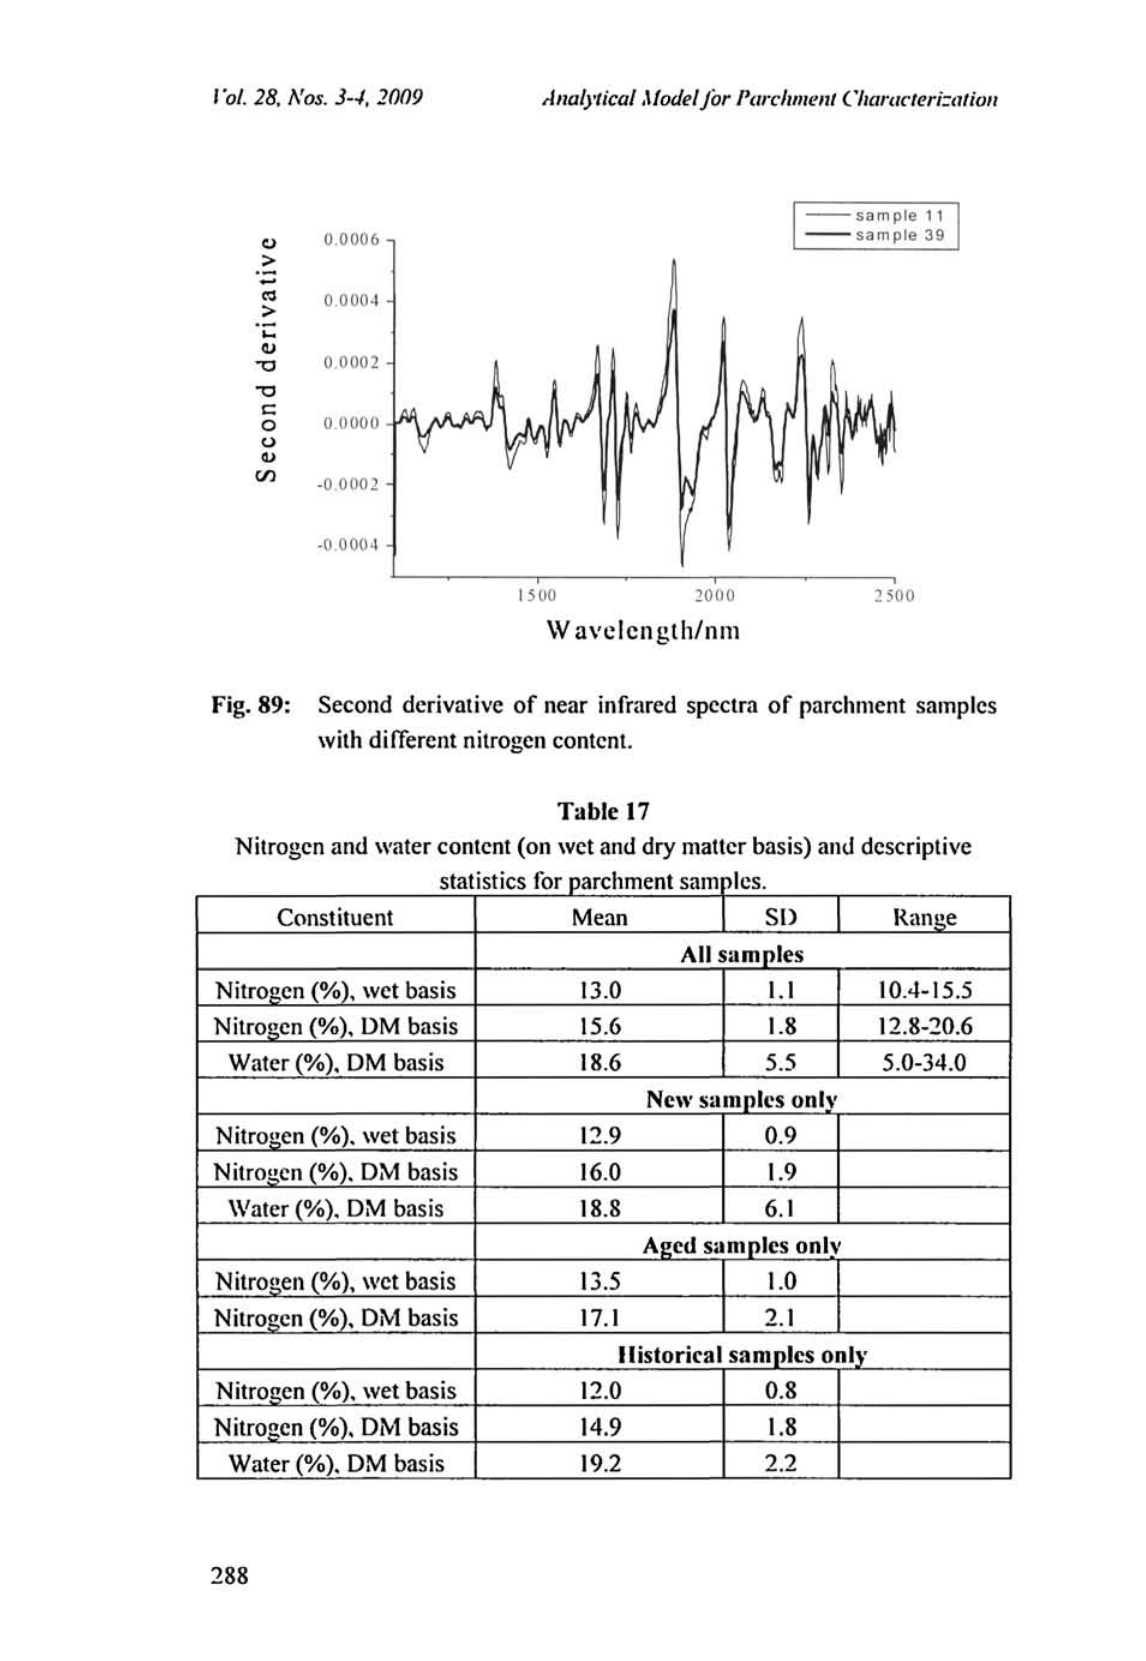
Fig. 89: Second derivative of near infrared spectra of parchment samples with different nitrogen content.